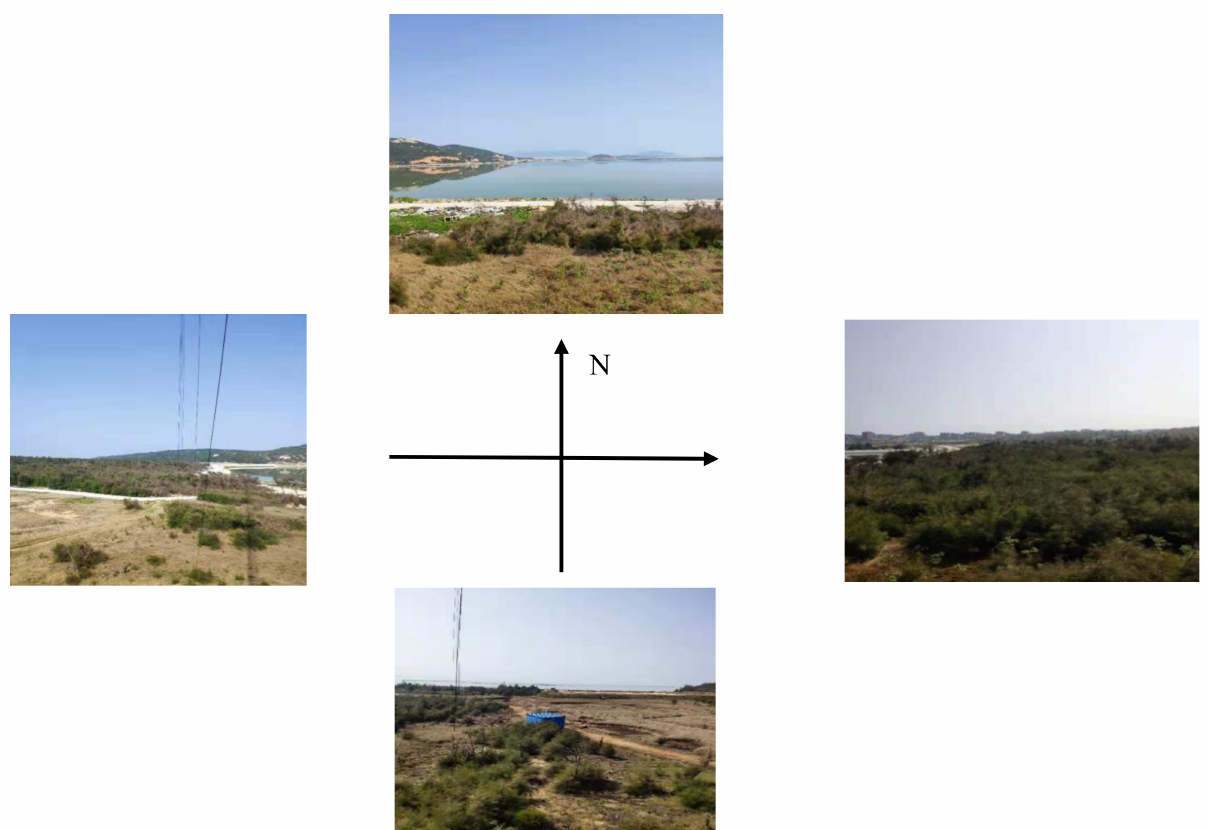
Figure 4. Photos of the terrain around the measurement station.